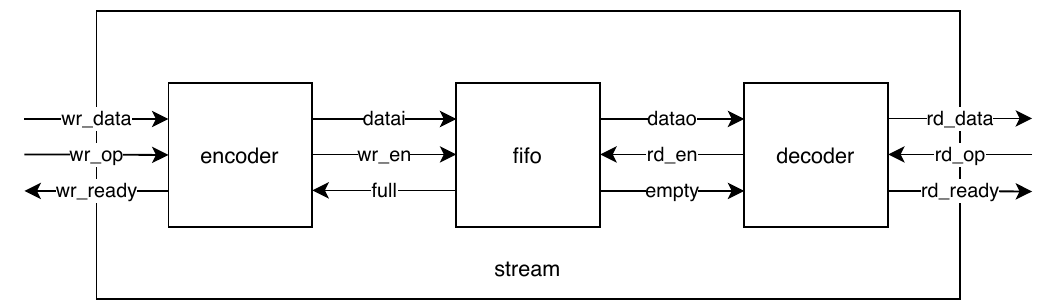
Figure 2. Stream module. For simplicity, global clock and reset connections are not shown. A dual-clock fifo may be used to decouple clock domains and in that case, the encoder should use the same clock as the write side of the fifo, and the decoder should use the same clock as the read side of the